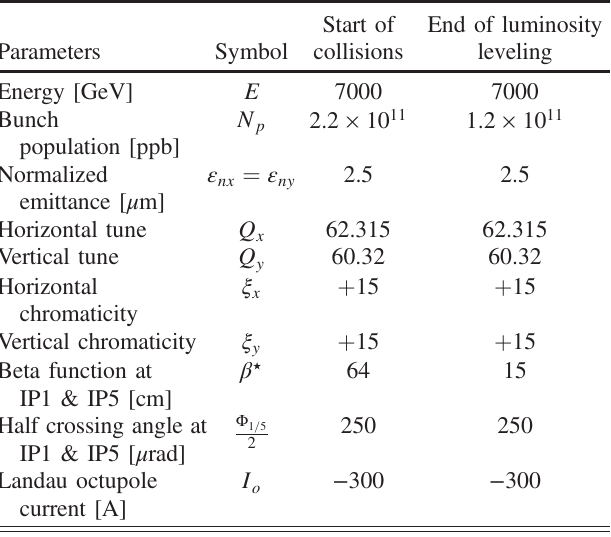
TABLE I. HL-LHC baseline configuration at the start of collisions and the end of the luminosity leveling.